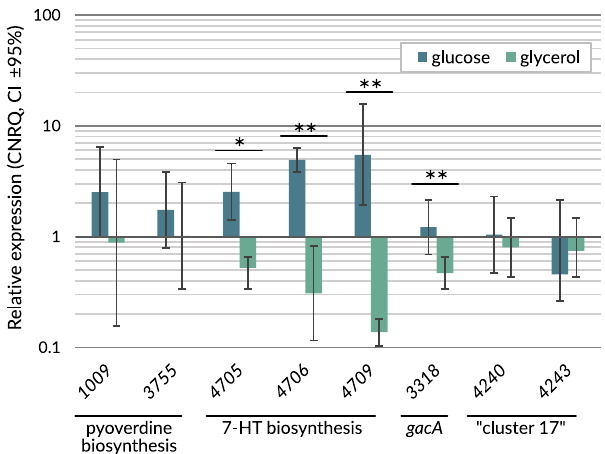
Figure 3. Comparison of relative expression (scaled to the mean CNRQ value calculated for each gene) of the chosen P. donghuensis P482 genes for bacteria cultured in the presence of glucose or glycerol as a sole carbon source in minimal medium M9. Error bars represent the 95% confidence interval (CI ± 95%). Statistically significant change in expression related to the particular carbon source used was observed for genes (the expression fold change value is given in brackets): 4709 (39.91), 4706 (16.01), 4705 (4.87), 3318 (2.6). Statistical analysis was performed using Student’s t-test, *) p < 0.05 **) p < 0.03. For clarity of the figure, loci references are represented by numbers